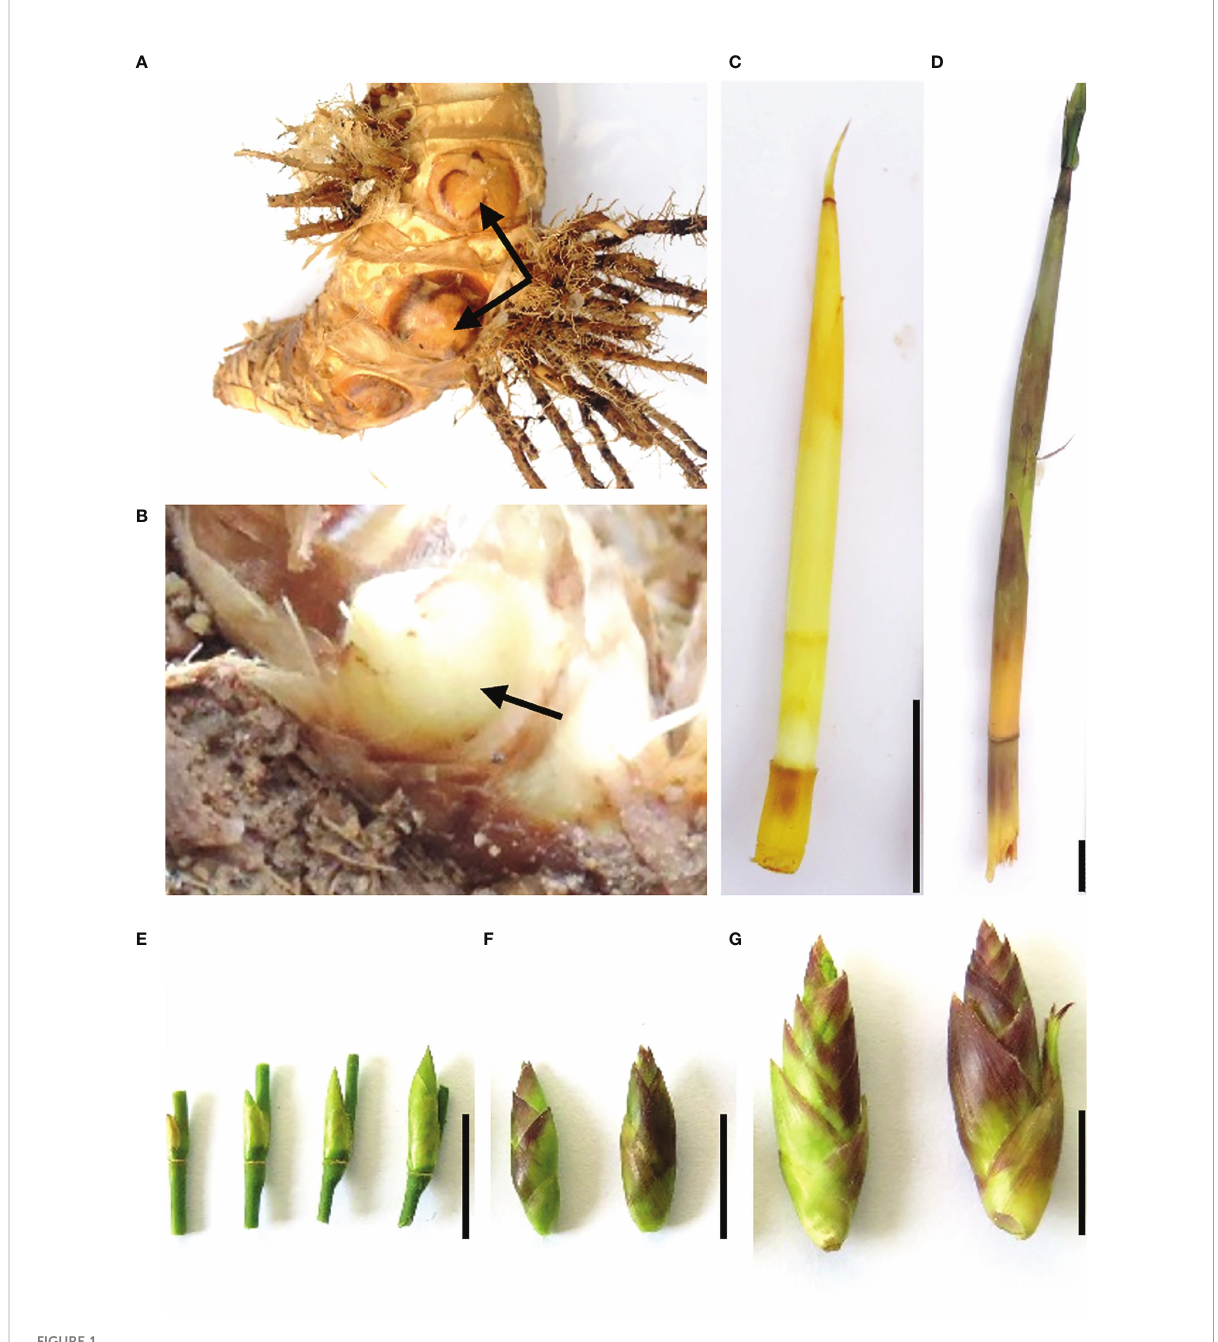
FIGURE 1 B. oldhamii ‘ Xia Zao ’ samples collected for the transcriptome. (A) culm buds from non- fl owering plants (NF3_Cb). (B) Culm buds from fl owering plants (F1_Cb). (C) Underground shoot buds from fl owering plants (F1_ShU). (D) Above-ground shoot buds from fl owering plants (F1_ShA). (E) Spikelet length <1 cm (F1_Fl1). (F) Spikelet length between 1 and 1.5 cm (F1_Fl2). (G) Spikelet length > 1.5 cm) (F1_ Fl3). Bar = 1